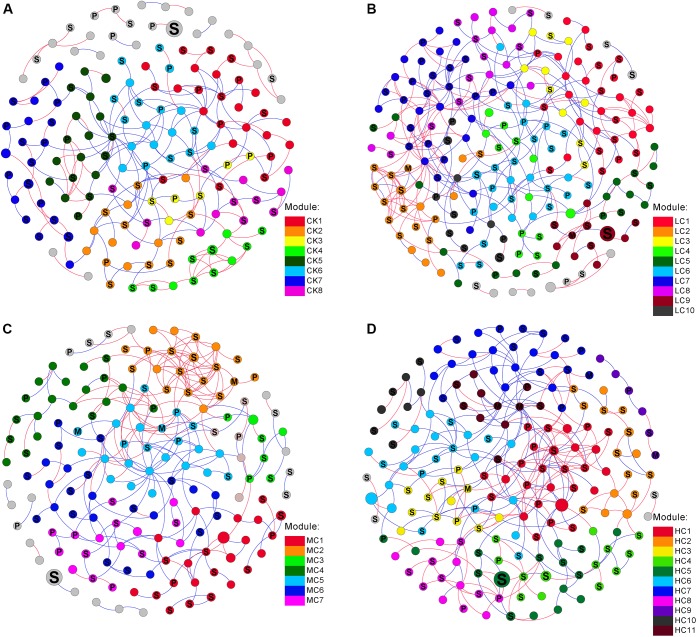
Networks of fungal communities in control (A), low level of compost (B), moderate level of compost (C), and high level of compost (D) amended soils. The size of each node is proportional to the relative abundance. Modules larger than five nodes are labeled with different colors in the respective network. The nodes were labeled as M (symbiotroph), P (pathotroph), and S (saprotroph) as predicted by FUNGuild. The red and blue lines indicate positive and negative connections between the nodes, respectively.